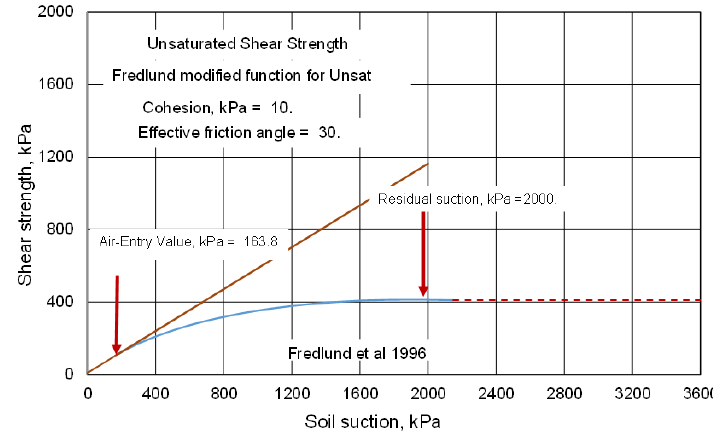
Figure 23. Proposed Fredlund [31] shear strength envelope for unsaturated soils.